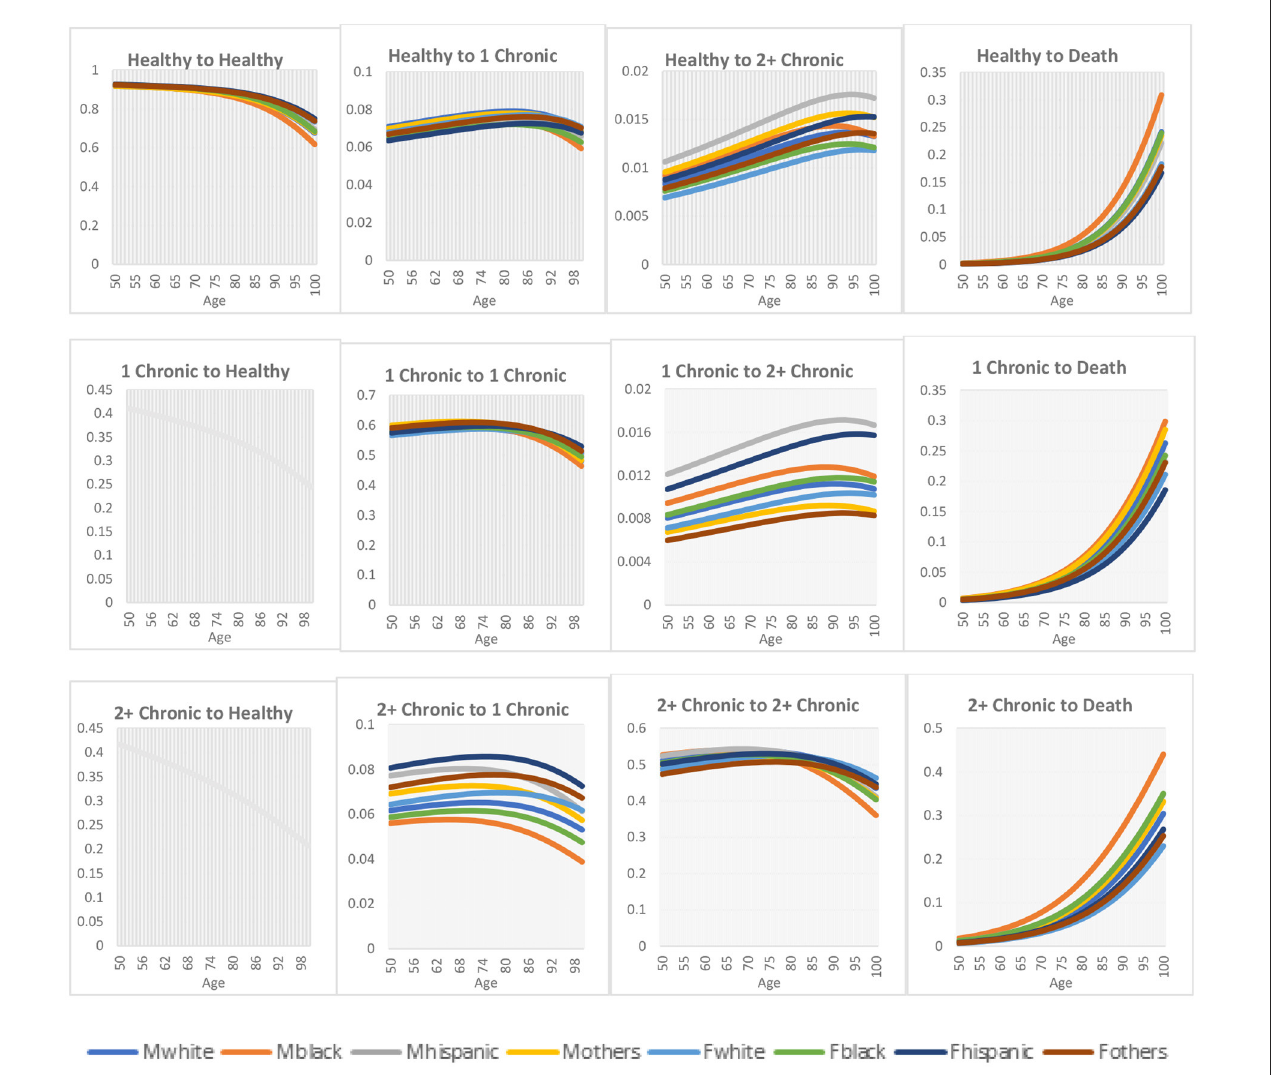
FIGURE1 Transition rates across health states. Mwhite: is male non-Hispanic white; Mblack: is male non-Hispanic black; Mhispanic: is male Hispanic; and Mother: is male other races; while Fwhite: is female non-Hispanic white; Fblack: is female non-Hispanic black; Fhispanic: is female Hispanic; and Fothers: is female other